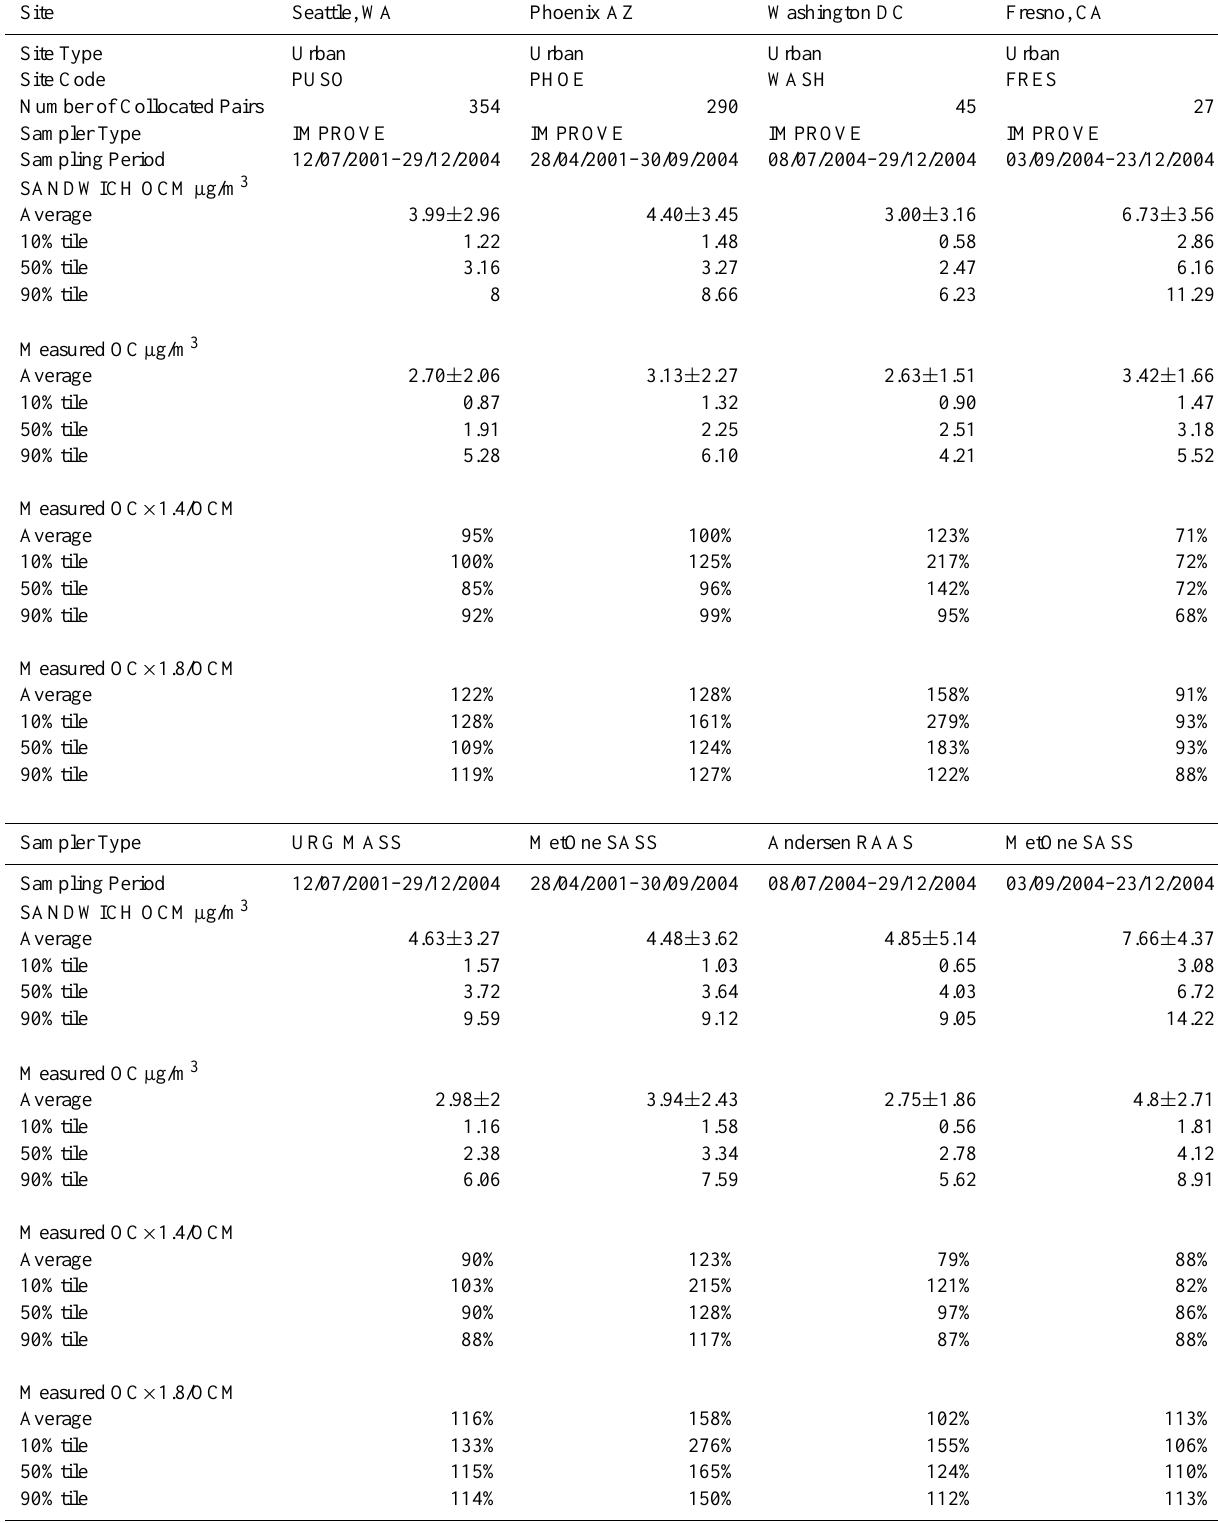
Table 7. Estimates of organic carbon mass (OCM) based on the SANDWICH method for the four collocated IMPROVE/STN sites. Site Seattle, WA Phoenix AZ Washington DC Fresno, CA Site Type Urban Urban Urban Urban PUSO PHOE WASH